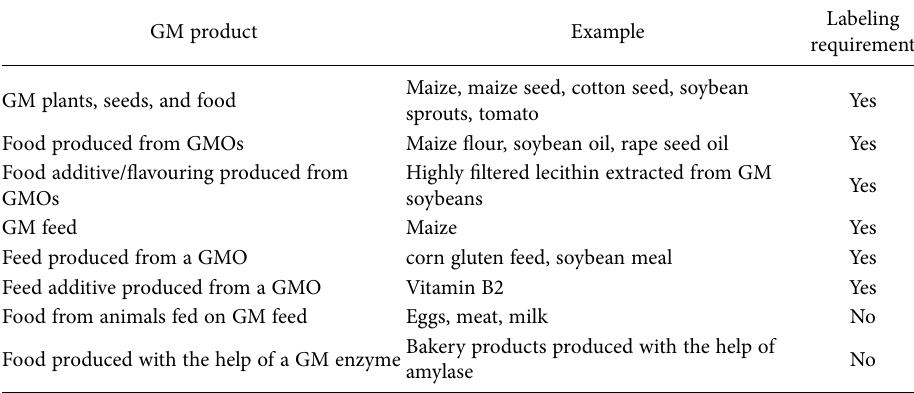
Feed additive produced from a GMO Vitamin B2 Food from animals fed on GM feed Eggs, meat, milk No